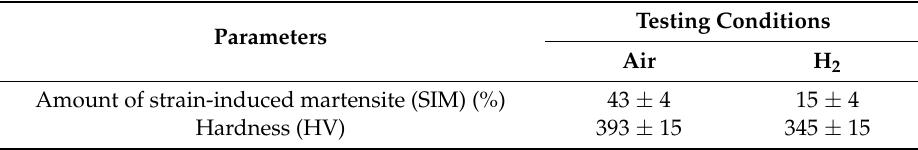
Figure 2 . ( a ) Ductile dimple fracture and ( b ) quasi-cleavage fracture of a 316 SS when tested in air and hydrogen, respectively. Table 1. Amount of SIM (vol.%) and hardness (HV) determined at or near the fracture surfaces of a 316 SS after RT tensile deformation in air and